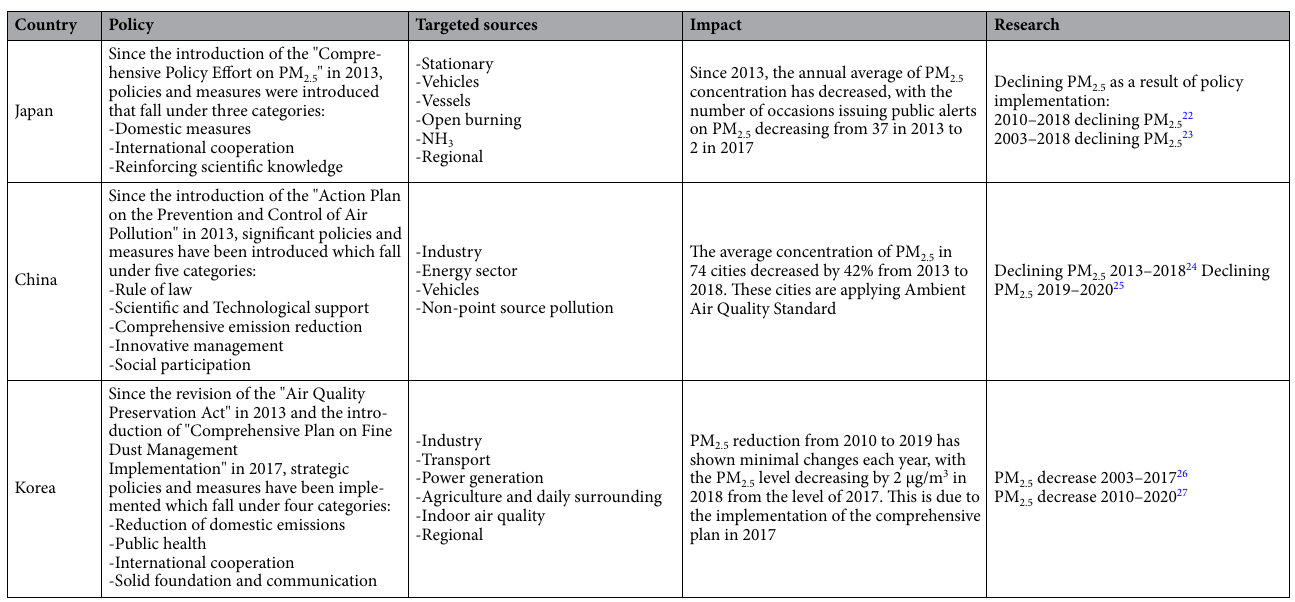
Table 1. Significant policies implemented by China, Japan, and Korea to improve air